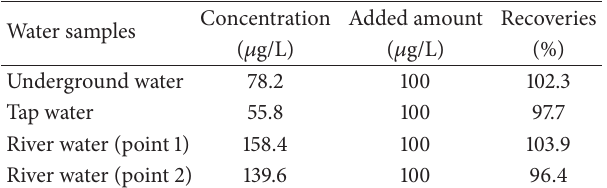
Table 2: Experimental recoveries of Sr 2+ in four water